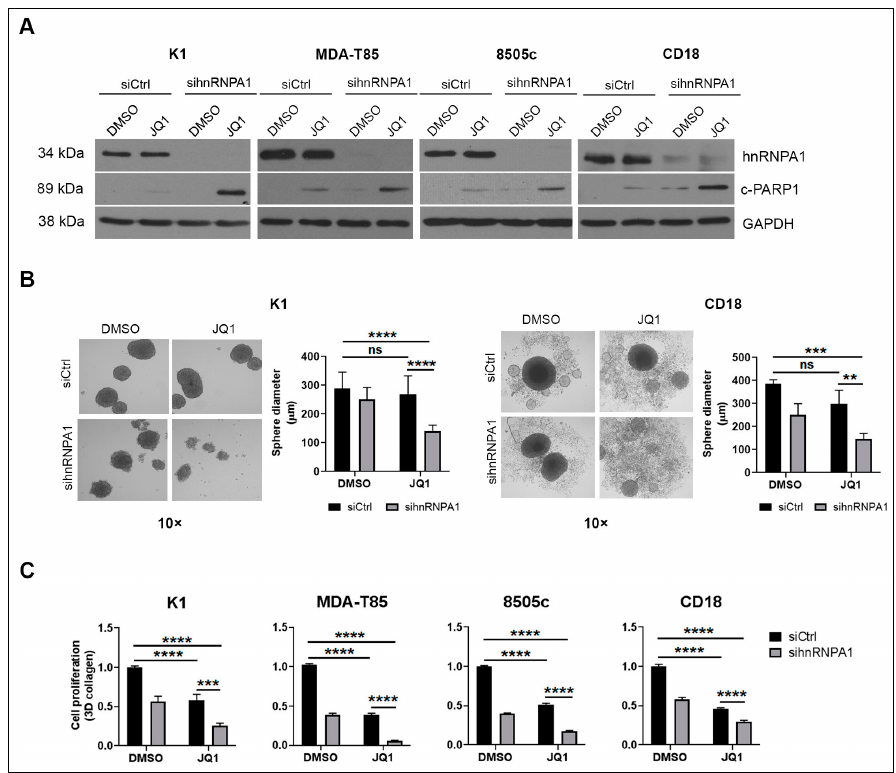
Figure 2. hnRNPA1 knockdown enhances the anti-tumor effects of BET inhibitors in cancer cells. ( A ) Cancer cells were transfected with siCtrl or sihnRNPA1 for 48 h, and then treated with JQ1 (1 µmol/L) for additional 24 h. Expression of hnRNPA1, c-PARP1 and GAPDH (loading